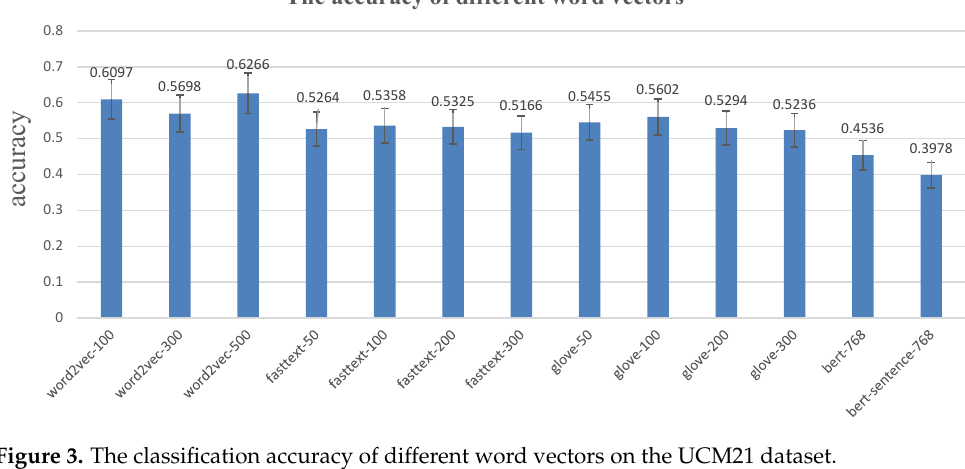
Figure 3. The classification accuracy of different word vectors on the UCM21 dataset.